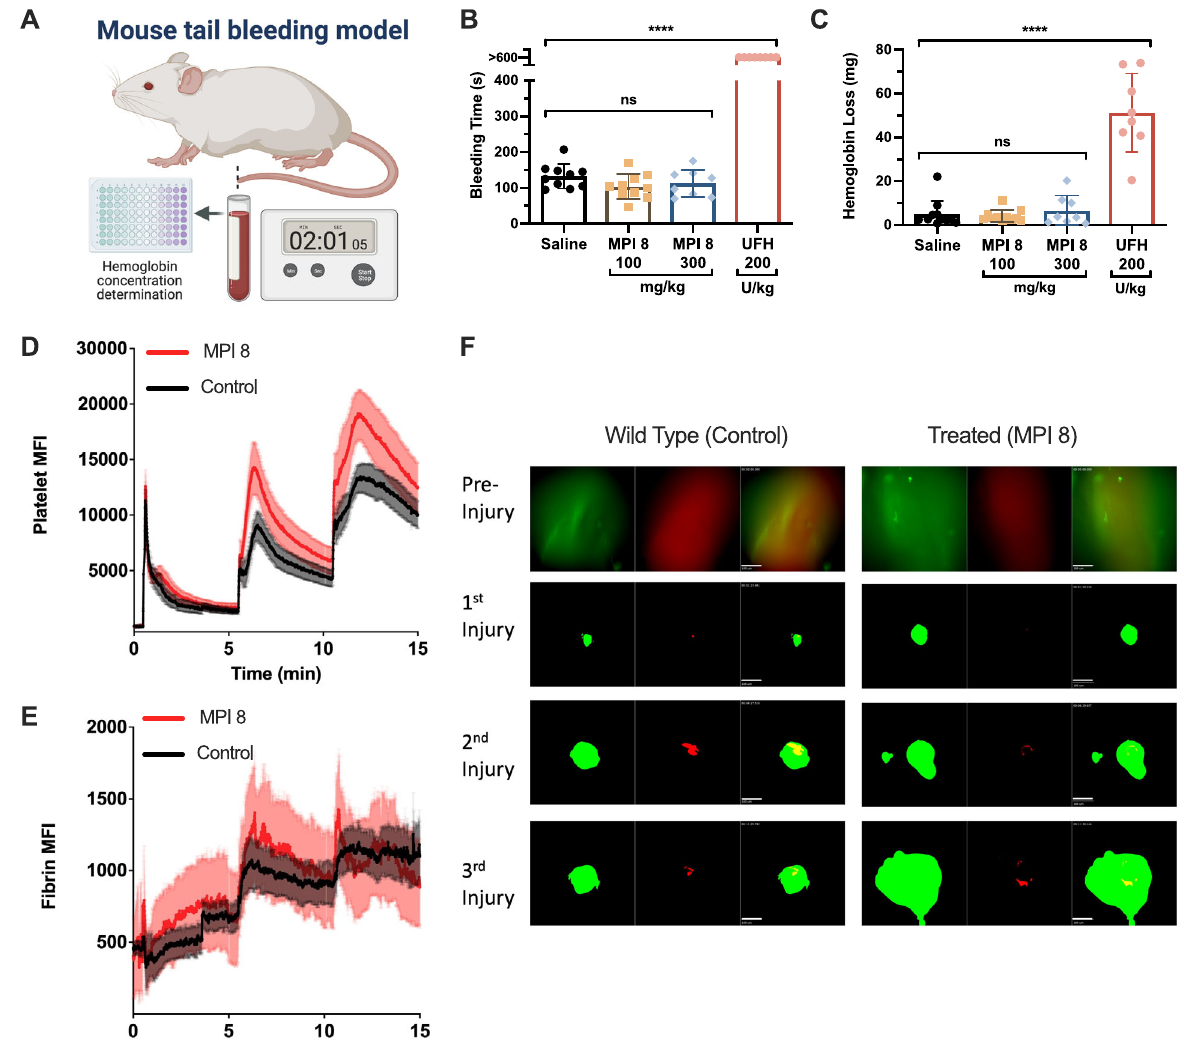
shaded regions are representative of the standard error (SEM). F Representative imagesofplatelet(green)and fi brin(red)hemostaticclotformationinresponseto arepetitivevascularinjuryofthesaphenousvein.Micewereinjectedwith200mg/ kg of the lead MPI 8 candidate. The scale bar is 100 µ m shown in the left lower corner of the composite image of panel 3 (third from left) for wild type (control) and treated (MPI 8) groups. All results represent mean values+/ − SD of n =8 mice per group. Results analyzed using ordinary one-way ANOVA, two-tailed, with Tukey ’ s multiple comparisons test. **** P <0.0001, ns notsigni fi cant. Figure6A was created with using